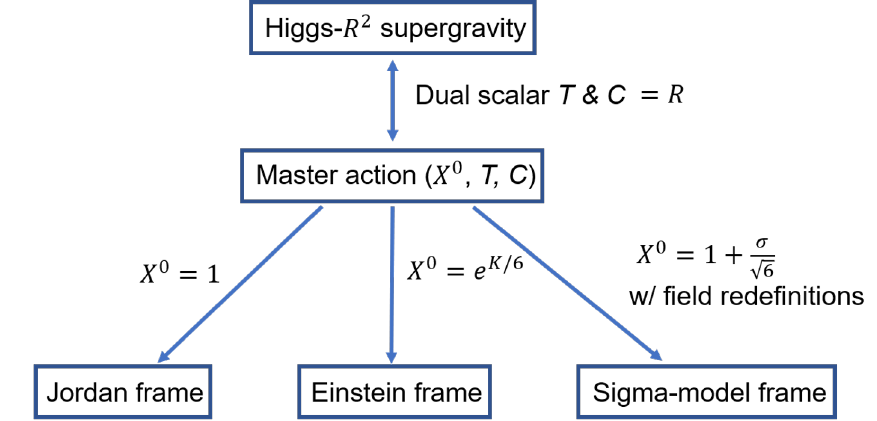
Figure 1 . Relation between different